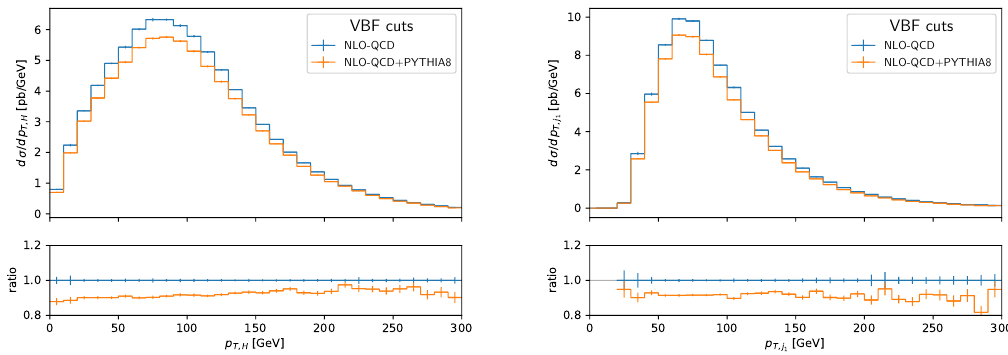
Figure 2 . Transverse-momentum distribution of the Higgs boson (left) and of the hardest tagging jet (right) at NLO-QCD (blue) and NLO-QCD+PS (red) accuracy within the VBF cuts of eqs. (3.5)– (3.8). The ratios of the NLO-QCD+PS to the NLO-QCD results are shown in the respective lower panels.